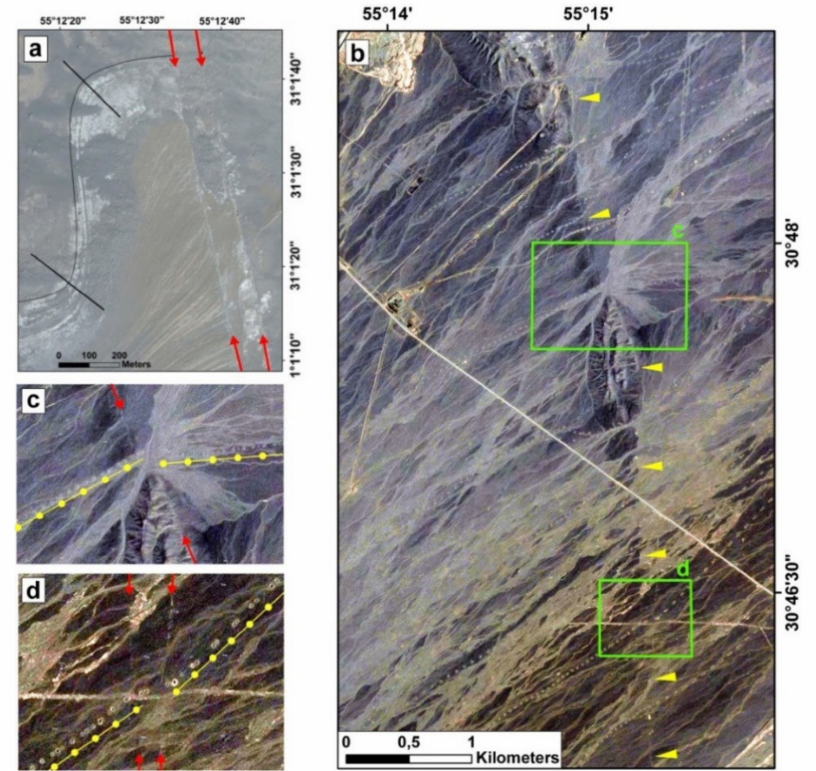
Figure 9. ( a ) Shear folding along the Anar fault zone. ( b ) The trace of the southern part of the Anar fault. ( c , d ) The deflection of the qanat at the closing of the fault trace. Therefore, according to the collected evidence, we can likely develop a tectonic model for the southern termination of the Anar fault system that looks like a flower structure forming a depressed area in the plain (Figure 10) [69]. Our data and the shape, nature, and general pattern of the Anar basin strongly suggest that the basin is an active negative flower structure.